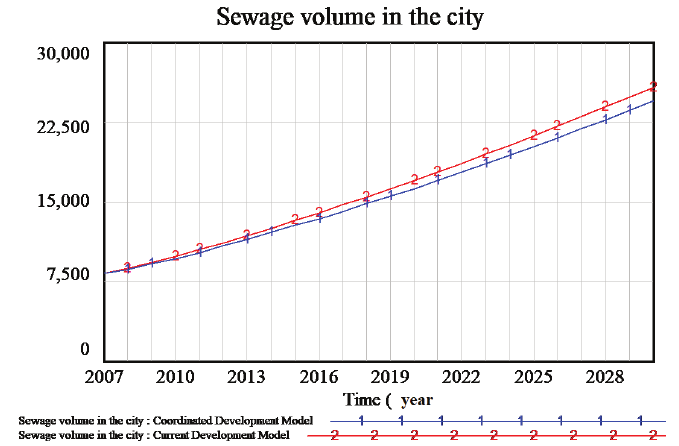
Fig. 7 Urban sewage volume simulation value(10,000